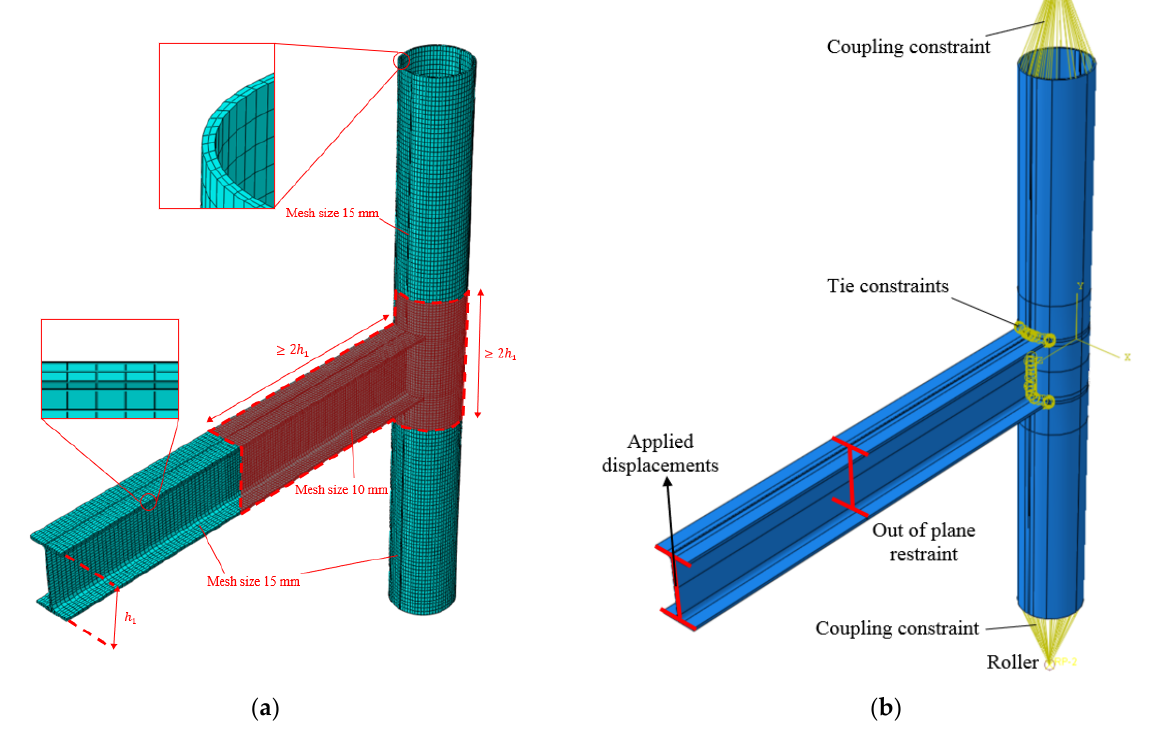
Figure 8. Mesh size selection ( a ) and finite element (FE) model ( b ). Materials 2020 , 13 , x FOR PEER REVIEW